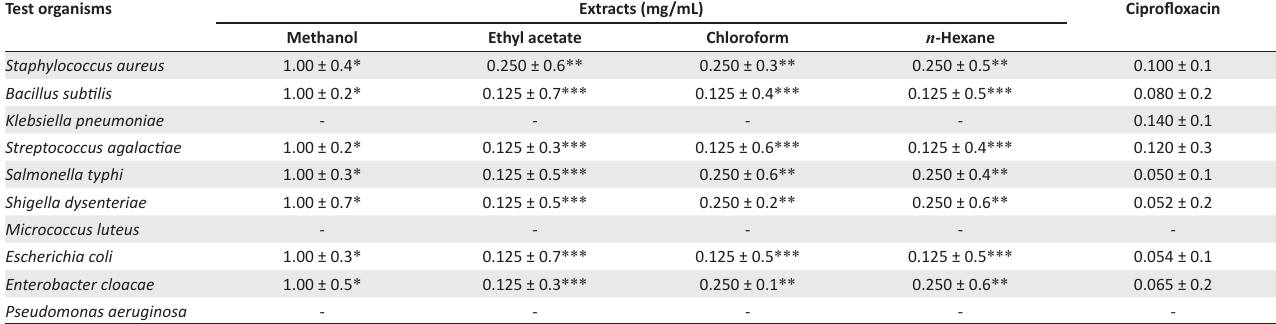
TABLE 3: Minimum inhibitory concentration in mg/mL of root extracts from P. oleracea . Test organisms